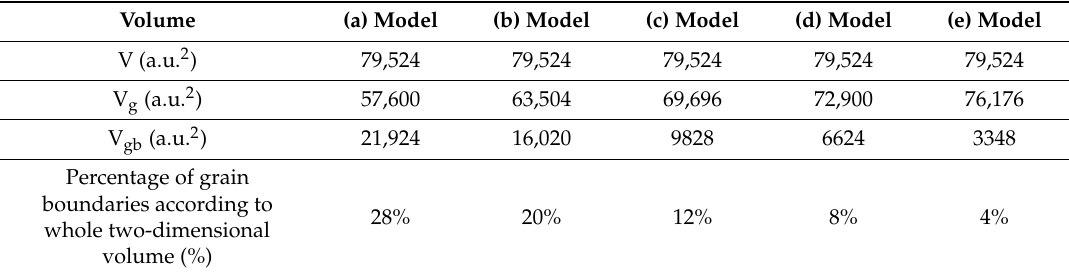
Figure 2. Geometry of models with different grain sizes, in a.u.: ( a ) 30, ( b ) 42, ( c ) 66, ( d ) 90, and ( e ) 138. Grain boundary width is fixed for all models at 6 a.u. Table 1. Comparison of two-dimensional volume for each model. V —two-dimensional volume of the test material, V g —grain two-dimensional volume, V gb —grain boundary two-dimensional volume.